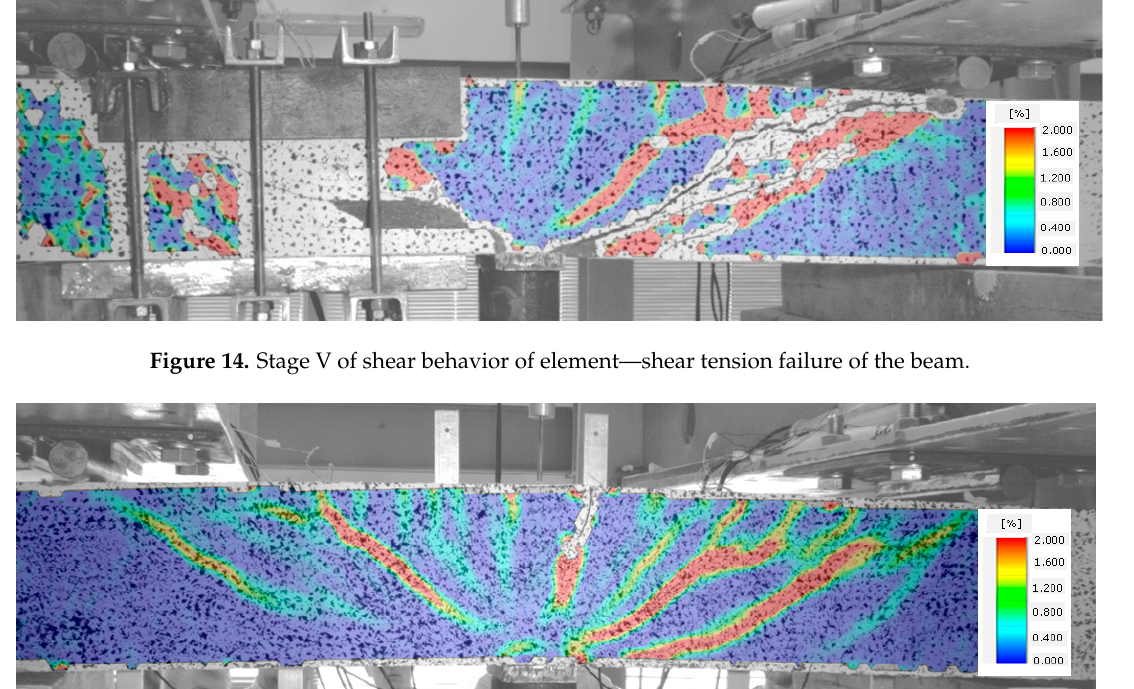
Figure 15. Stage V of shear behavior of element—element bending failure through yielding of the tensioned reinforcement.